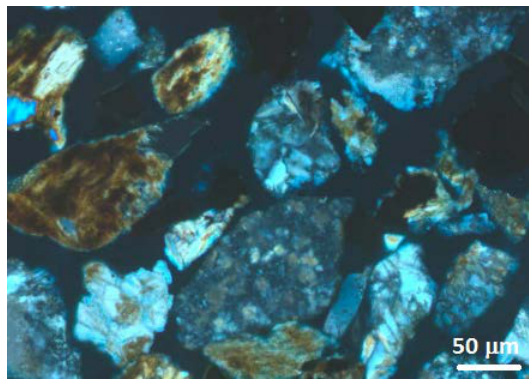
Figure 1. Polarization microscopy image of A1F-Bulk sample under crossed polarizers, showing heavily altered gangue grains.